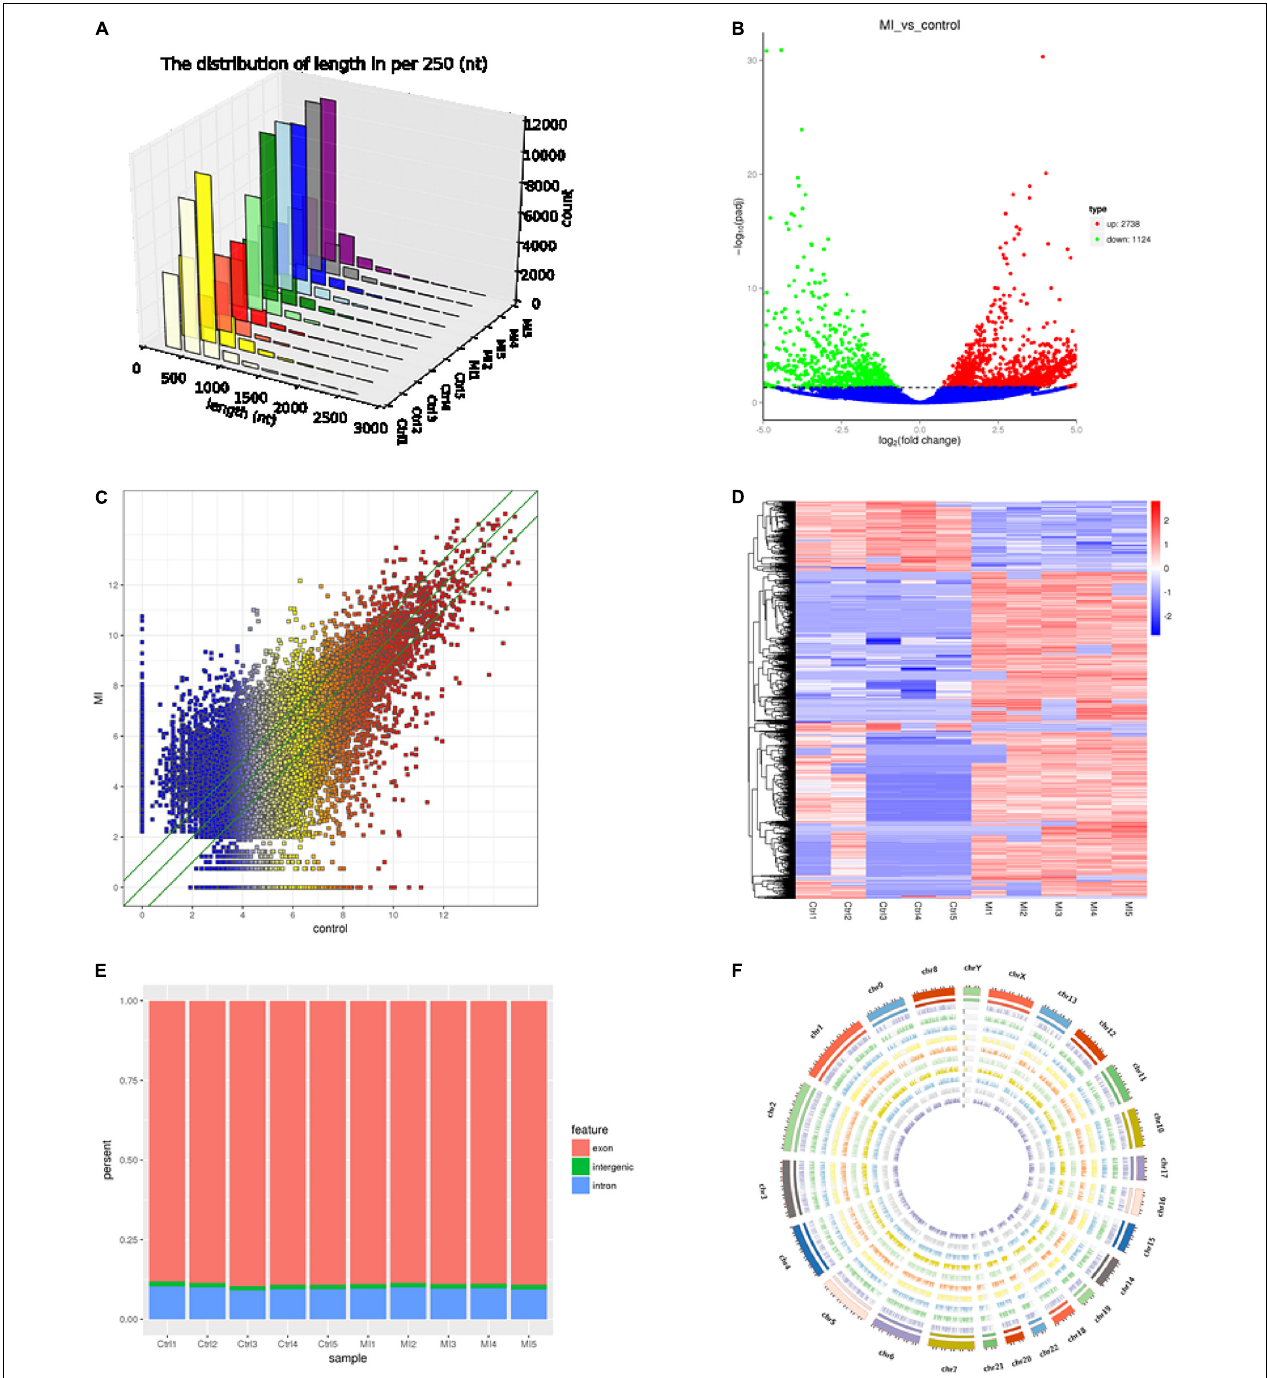
FIGURE 1 | Landscape of circRNA profiles. (A) Length distribution of circRNAs (29). (B) Volcano plot of differentially expressed circRNAs in MI. The abscissa represents the fold change of circRNA in different groups, and the ordinate represents the level of statistical significance. The plots in the figure represent circRNAs. The blue points denote no significant difference, red points denote that the expression levels of circRNAs are significantly upregulated, and green points denote that the expression levels of circRNAs are significantly downregulated (31). (C) The scatter plot presents the circRNA expression variations between the MI and paired healthy controls. The nodal increment of the x and y axes is 1 (log2FC = 1). The circRNAs above the top green line and below the bottom green line indicate greater than 2-fold change (TPM > 2) between the MI and control. (D) Hierarchical cluster analysis shows the differential expression profiles of circRNAs among MI samples and normal samples. The upregulated and downregulated circRNAs are colored in red and blue, respectively. Ctrl1-Ctrl5 represent healthy controls, and MI1-MI5 represent MI patients. (E) Histogram shows the percentage of circRNA from different genomic origins. (F) Pie chart shows the differentially expressed circRNAs based on chromosomal